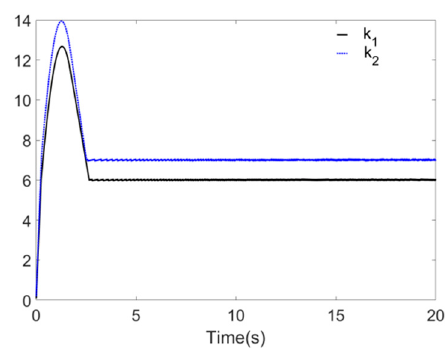
Figure 6. Synchronization errors.